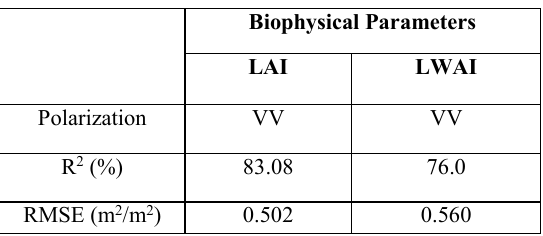
Table 5.Performance indices for estimation of LAI and LWAI using modified